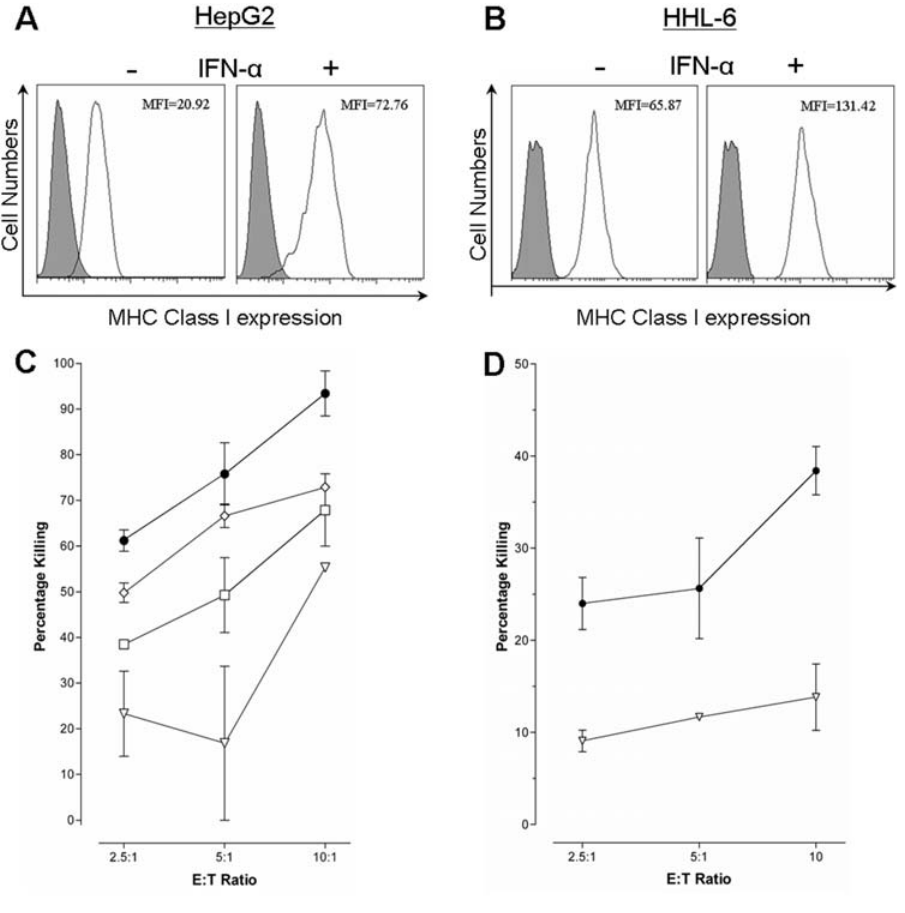
Figure 1. IFN- a reduces hepatocyte sensitivity to CTL cytotoxicity. Hepatocytes have been described as expressing low to no MHC Class I. As expected, IFN- a treatment increased the levels of MHC Class I on HepG2 ( A ) and HHL ( B ); filled curve represents an isotype control, the solid line represents the MCH Class I expression. C ) HepG2 cells were stimulated for 16 hours with a serial dilution of IFN- a at 0 IU/ml (closed circles), 10 IU/ml (open diamonds), 100 IU/ml (open squares), and 1000 IU/ml (open inverted triangles), prior to cytotoxicity assay with the CTL line 2. Treatment with IFN- a reduced the HepG2 cells sensitivity to CTL cytotoxicity in a dose dependent manner. D ) This phenomenon was also found with the novel human hepatocyte cell lines (HHL). HHL-17 cells were either left untreated (closed circles) or stimulated for 16 hours with 1000 IU/ml (open inverted triangles) prior to co-incubation with the CTL line 1.